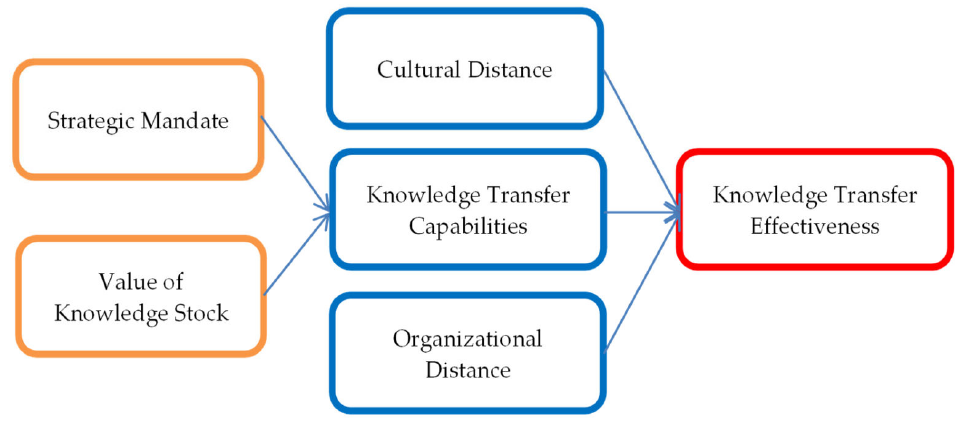
Figure 1. Effective knowledge transfer in multinational corporations. Source: Adapted form [23], p.